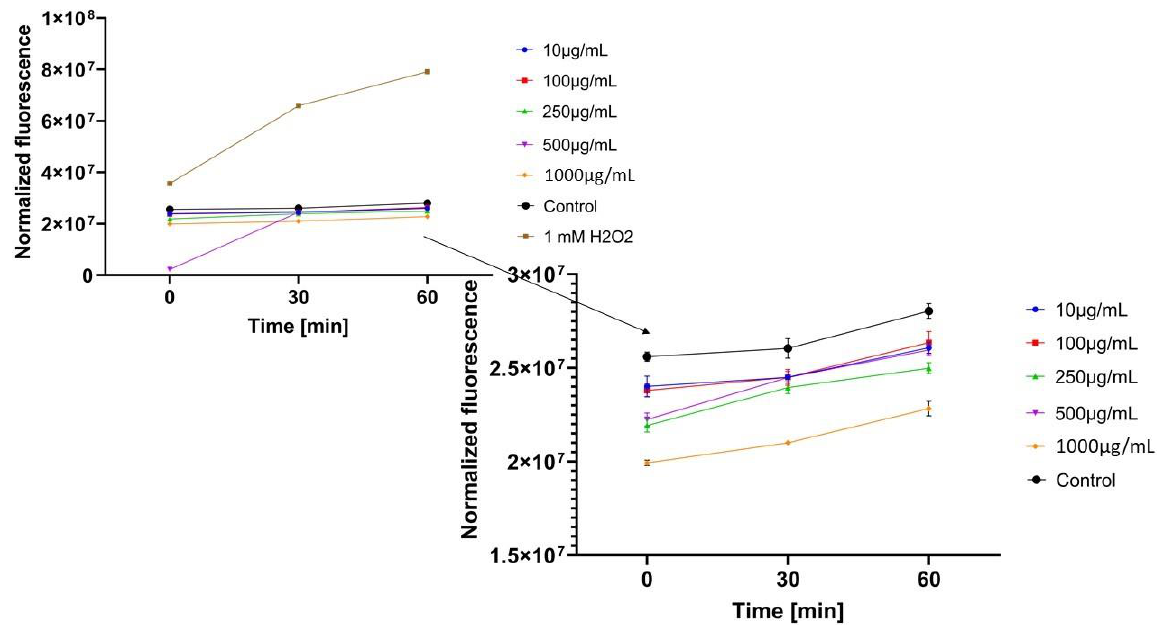
Figure 8. The effect of Clitoria ternatea L. extract on the 2’,7’-dichlorofluorescein (DCF) fluorescence in fibroblast cells(BJ). The data are expressed as the mean ± SD of 3 independent experiments, each of which consisted of 3 replicates per treatment group.